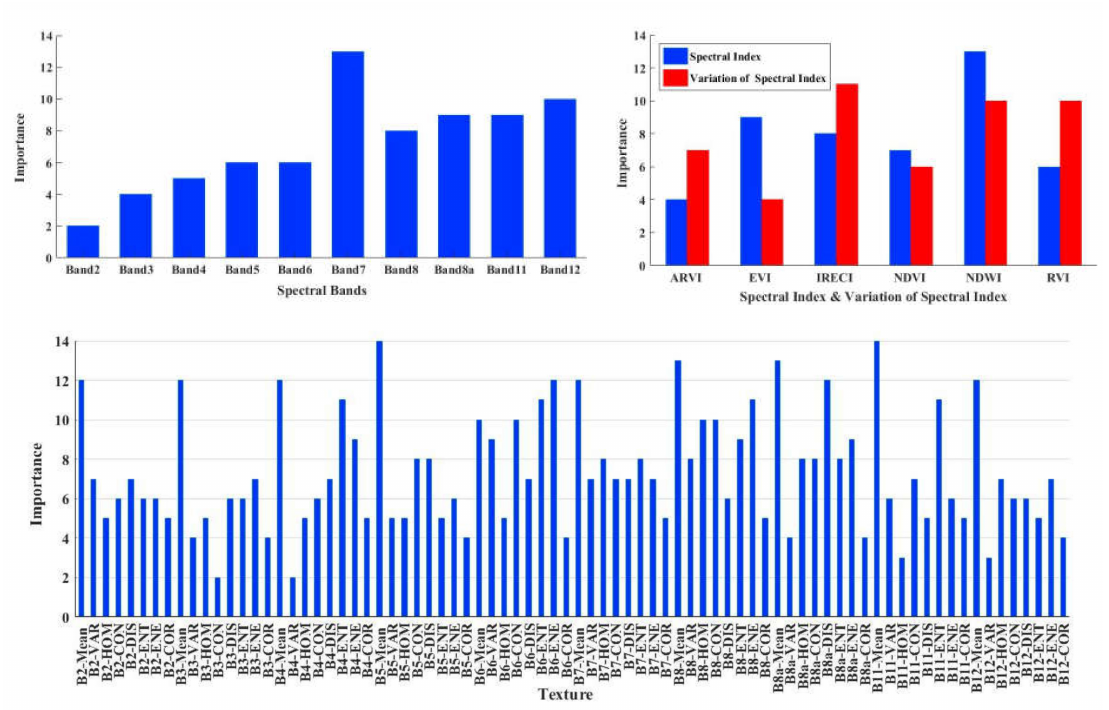
Figure 6. Importance of di ff erent features based on the summation of the number of features, which are selected by RF-variable importance and RF-PSO methods. B2–B12 are the Sentinal-2 bands from blue to SWIR, respectively (bands detail in [49]).